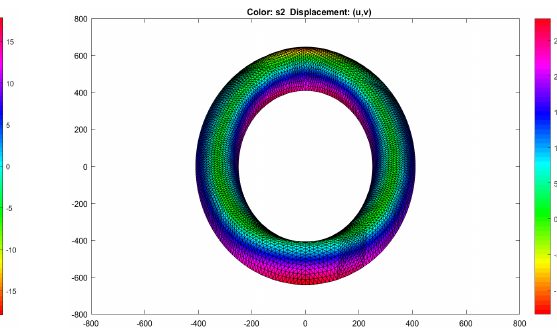
Fig. 4: Plot for Shear stress of the tire sidewall.